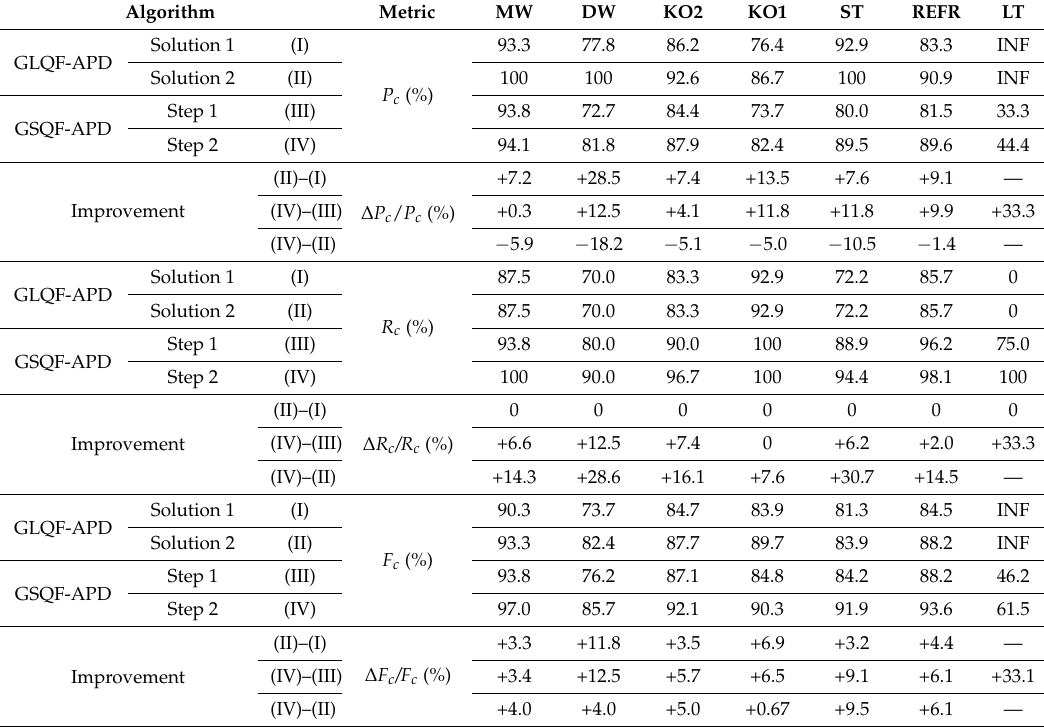
Table 1. Performance improvement of the proposed GSQF-APD algorithm compared with